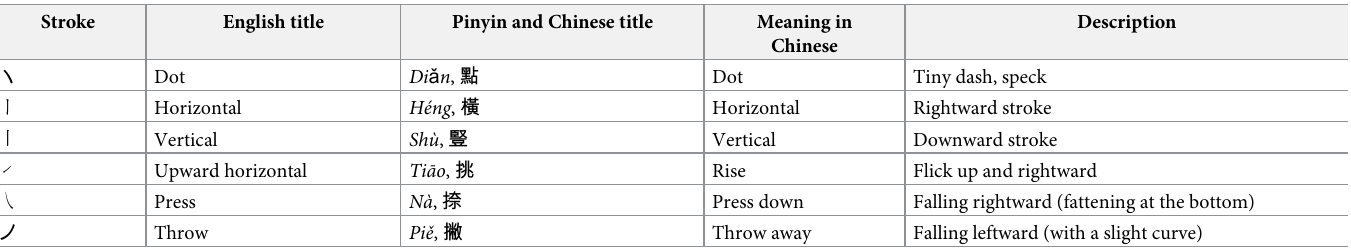
Table 1. Basic Chinese character